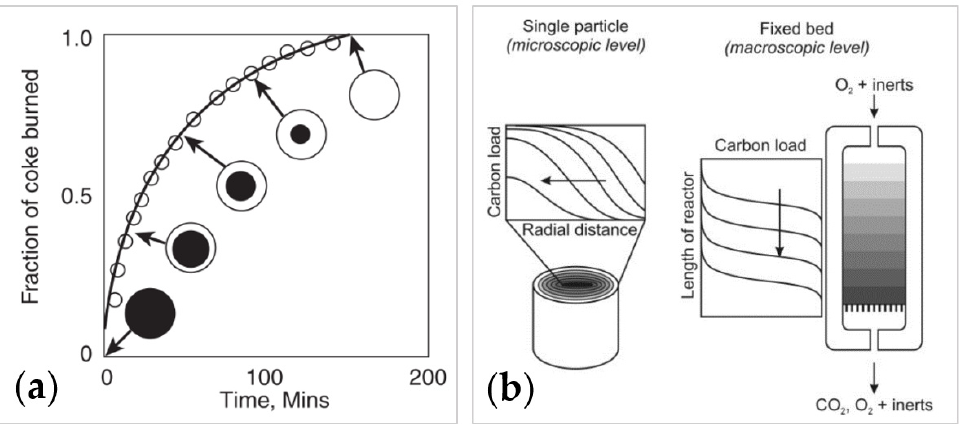
Figure 13. ( a ) Shell progressive regeneration of fouled pellet following shrinking-core model (SCM). Richardson et al. [109]; ( b ) Coke burn-off during the regeneration of coked catalyst pellets in a fixed bed reactor. Müller et al.